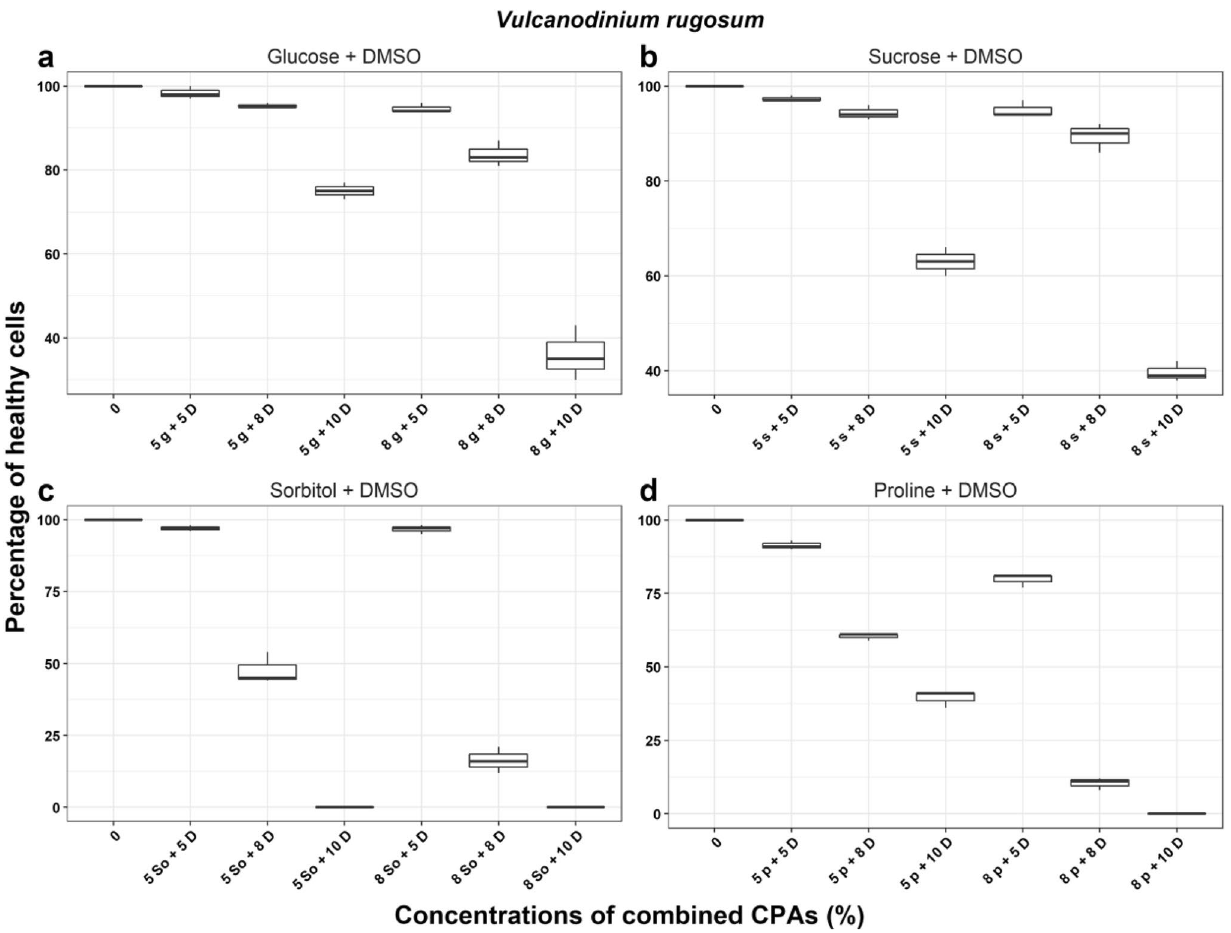
Figure 1. The percentage of healthy Vulcanodinium rugosum cells after treatment with combined cryoprotectant agents (CPAs) after one week incubation. g Glucose, s Sucrose, D Dimethyl sulfoxide, So Sorbitol, p